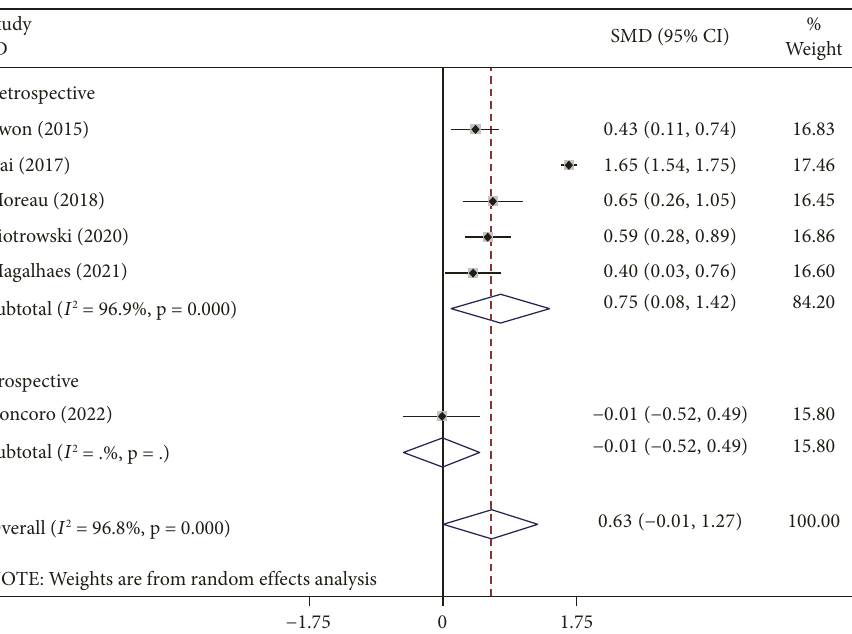
Figure 3: Subgroup analysis of differences in the NLR level between hospitalized cirrhotic patients who developed infection compared to those who did not, according to the study design.